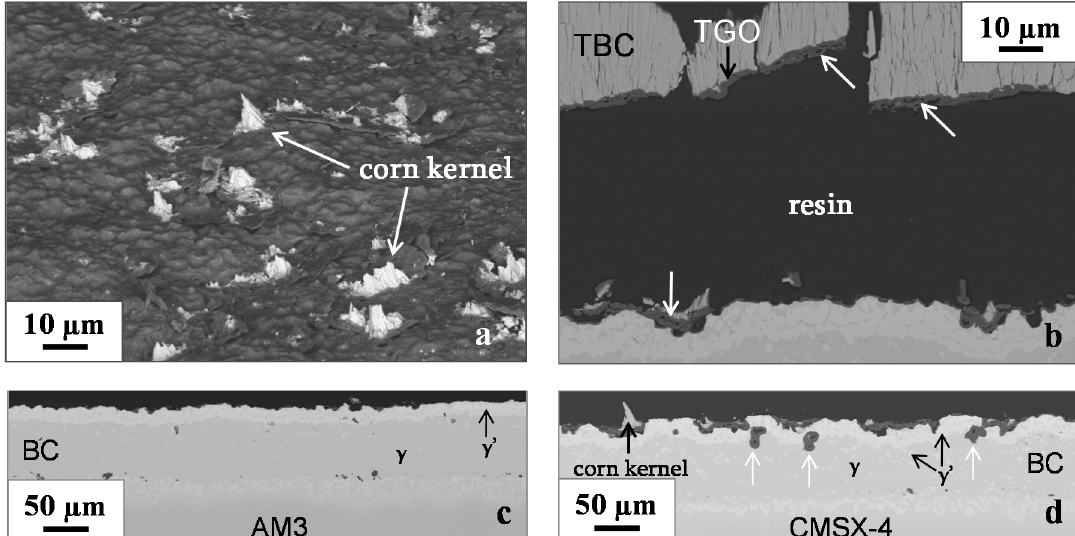
Figure 9. ( a ) Tilted VPS-Pt coating surface after spallation; ( b , c ) Cross-sections of the AM3-VPS-Pt TBC system after 92 cycles; ( d ) Cross-section of the CMSX-4-VPS-Pt TBC system after 199 cycles. The white arrows identify ( a ) the cavities within the TGO and ( c ) the oxide that locally penetrated deep within the bond-coating. Thermal cycles of 1 h at 1100 °C, with a high-flow air cooling. SEM images in BSE mode.